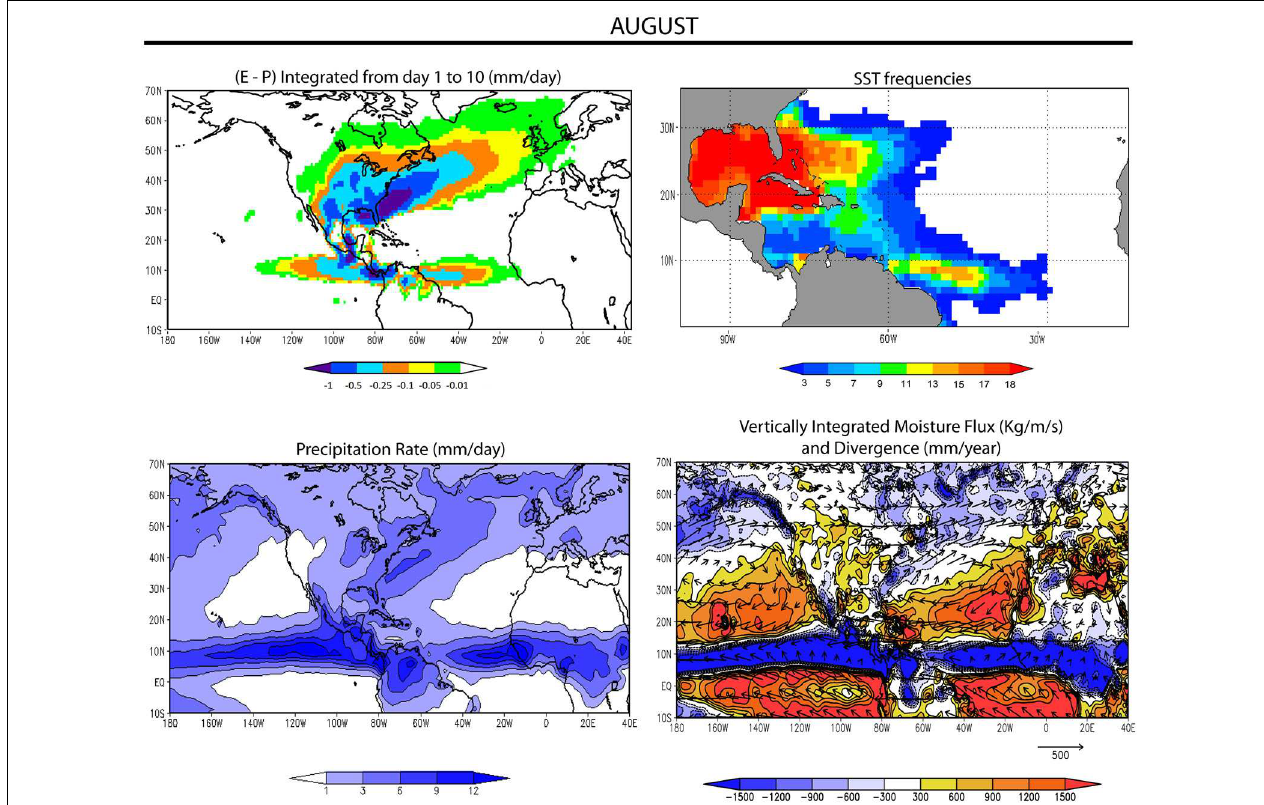
FIGURE 4 | As Figure 1, for